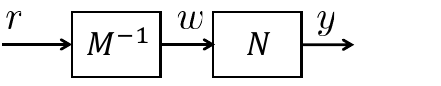
Figure 2. Output response using an operator-based control